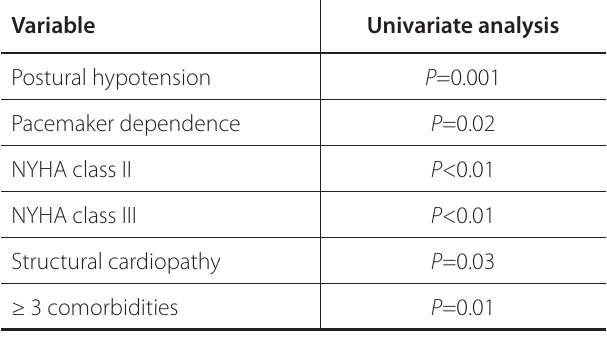
Table 3 . Significance of the variables associated with the occurrence of syncope in patients with pacemaker